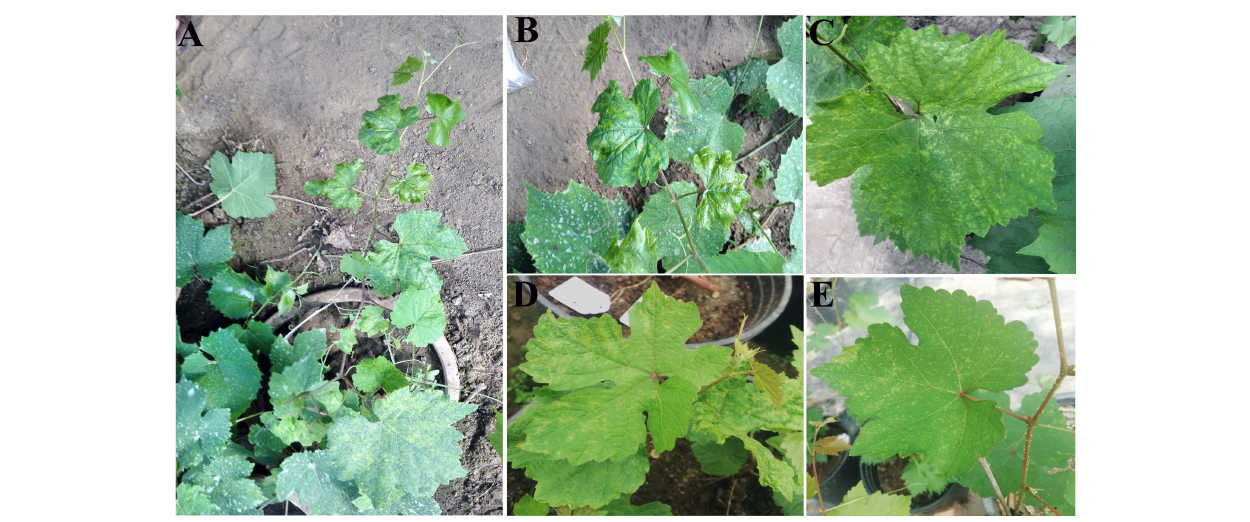
FIGURE 1 | Symptoms on the leaves of a “Shennong Jinhuanghou” (SJ) grapevine infected with grapevine emaravirus A (GEVA). (A) GEVA-infected SJ plant; (B) chlorotic mottling and shrinking symptoms on GEVA-infected leaves; (C) chlorotic mottling symptoms; (D,E) chlorotic mottling on leaves of cut seedlings propagated from the GEVA-infected